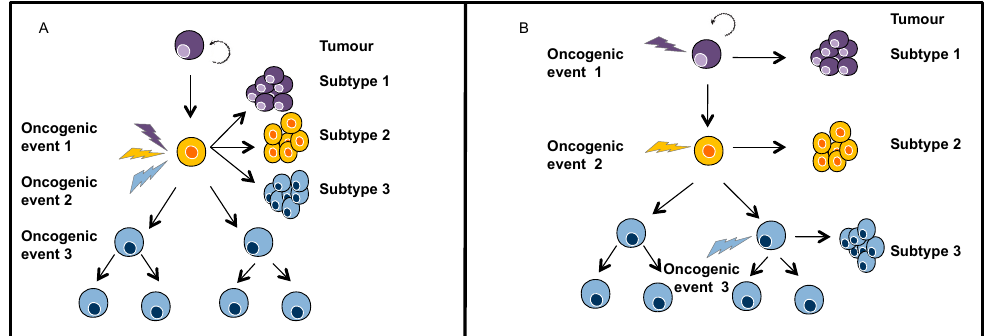
Figure 2. Two models of inter-tumour heterogeneity: ( A ) In the genetic and/or epigenetic mutation model, mutations/modifications primarily determine the phenotype of the tumour. For this reason, different mutations/modifications result in different tumour subtypes; and ( B ) In the cell-of-origin model, different cell populations in the lineage hierarchy are used as the cells of origin for the different cancer subtypes.